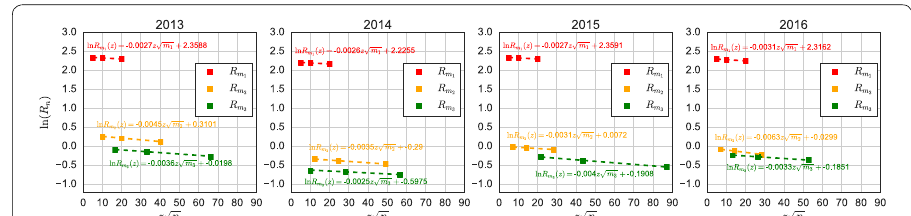
Fig. 15 Slope fitting for diffusivity estimation example. The linear fit between ln ( R n ) and z √ n is shown for the three dominant harmonics ( n